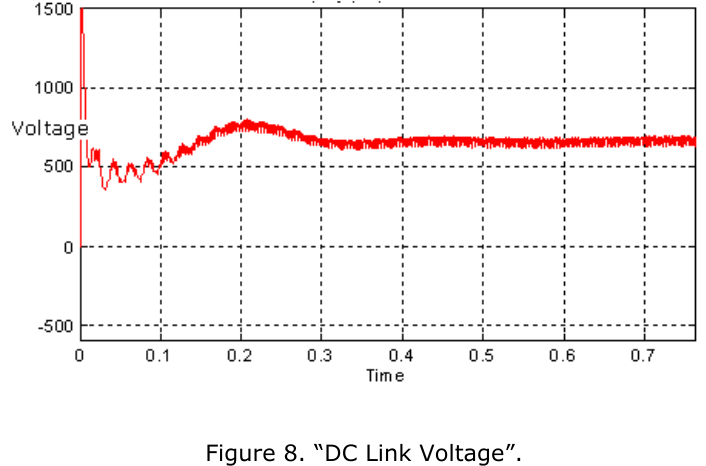
Figure 8. “DC Link